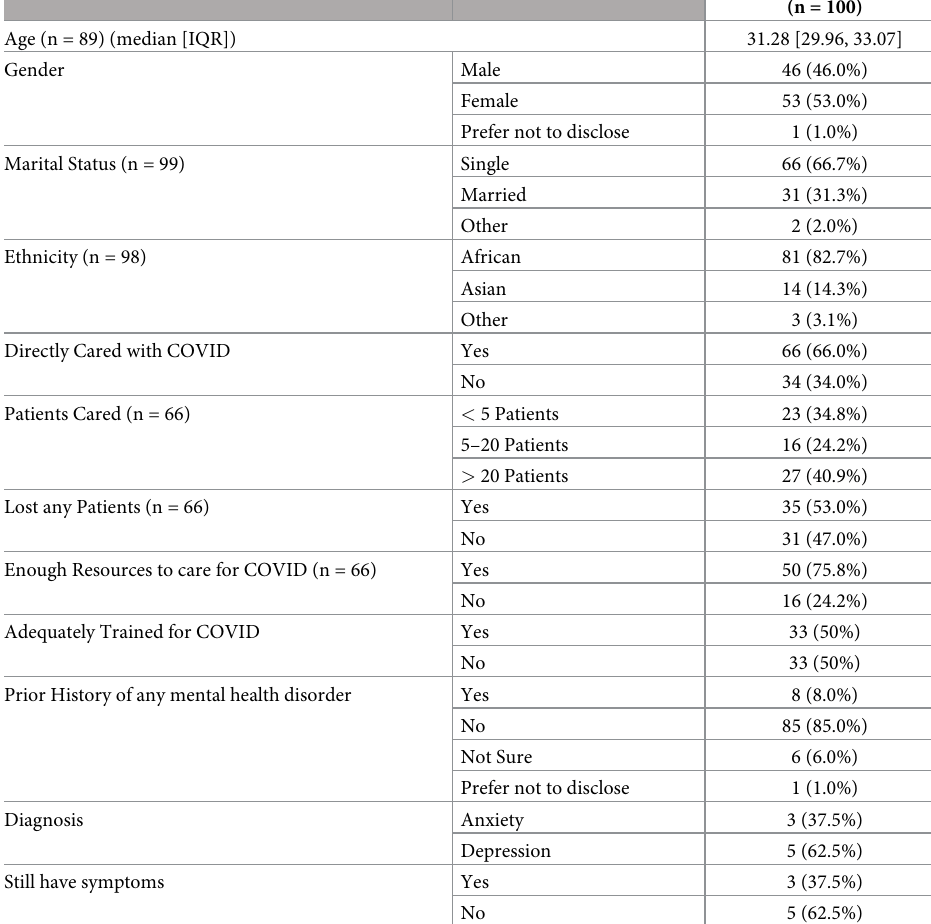
Table 1. Baseline characteristics of study participants (N =